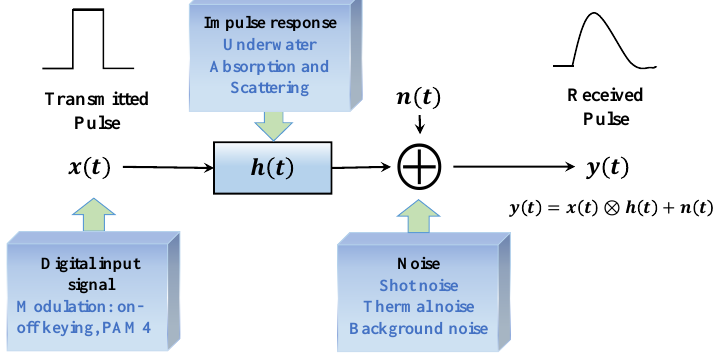
Figure 1. Model of UWOC channel.